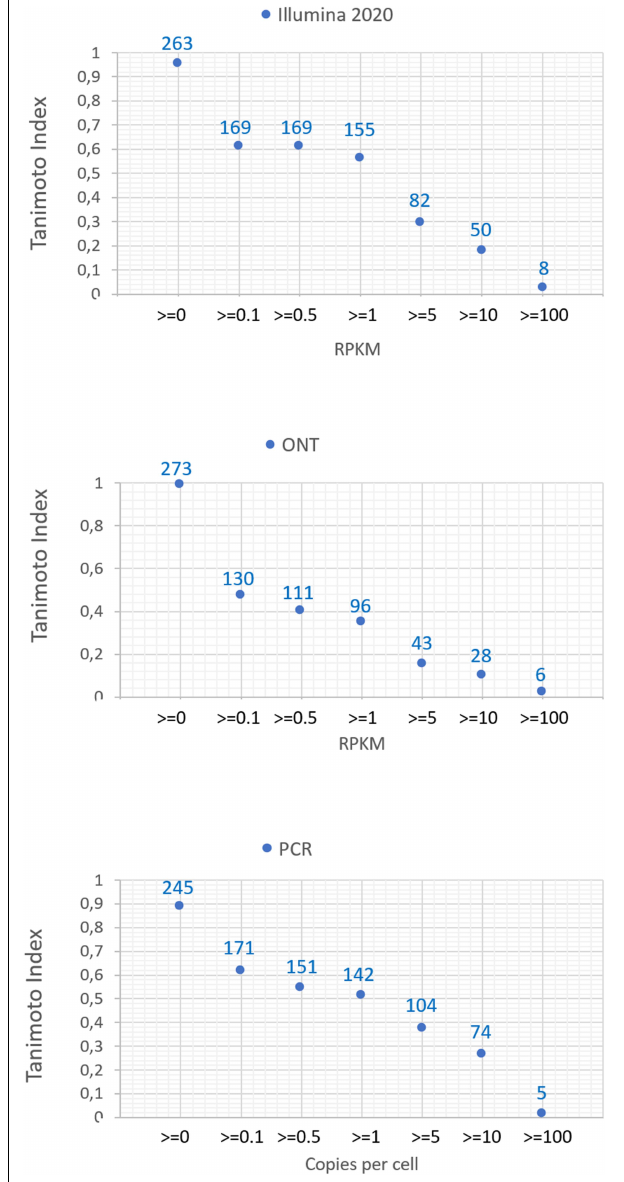
FIGURE 2 | Dependence of the number of detected transcripts of chromosome 18 for various platforms (Illumina 2020 data, ONT, and qPCR) on the cutoff level and the concordance of the results obtained with the known genome of chromosome 18.